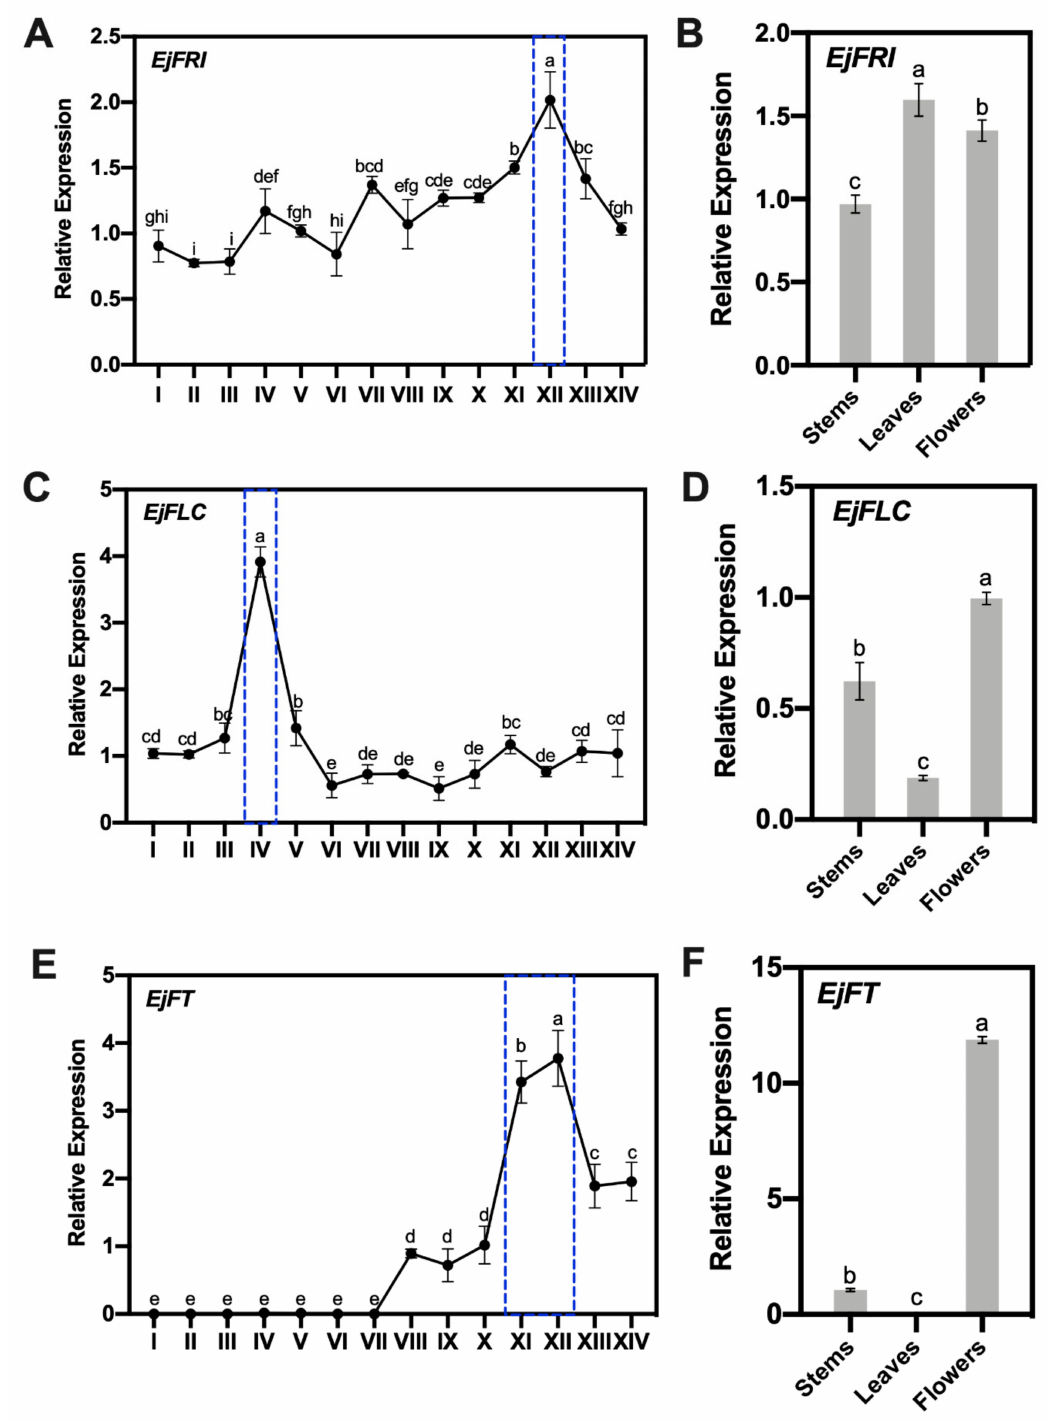
Figure 3. Relative expression patterns of EjFRI in loquat. ( A , C , E ) Relative expression levels of EjFRI , EjFLC and EjFT in the developmental stages of apical buds. Roman numerals (I–XIV) in the X-axis indicated the developmental stages of apical buds (see Figure 2). ( B , D , F ) Expression pattern of EjFRI, EjFLC and EjFT in di ff erent tissues of loquat. The stems, leaves and flowers used in B, D and F were collected on the same day, which was the full-bloom stage (November 23th). Data presented mean ± SD of three biological replicates. Letters above the bars indicate significant di ff erences at p < 0.05 (Tukey–Kramer